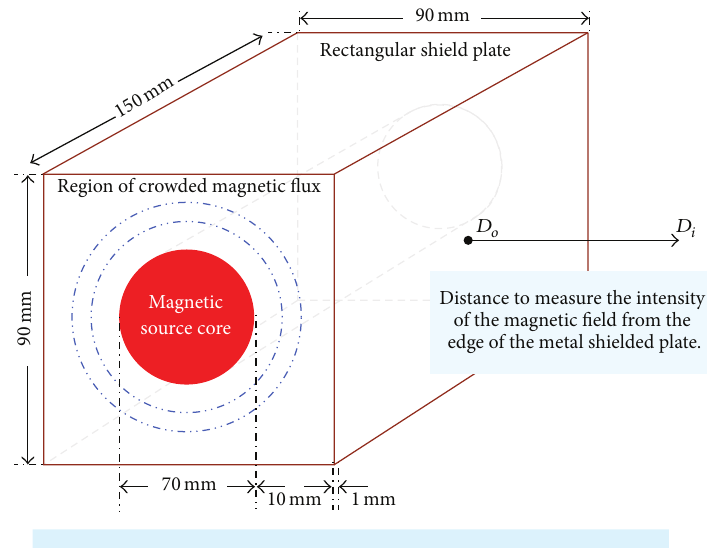
Figure 2: Schematic of rectangular shield plate and distance to measure the intensity of the magnetic field. The material used in the analyses consists of copper, lead, steel, and transformer steel ( 𝐷 𝑜 is the edge of metal shield plate, and 𝐷 𝑖 is the distance of magnetic field which is reduced).